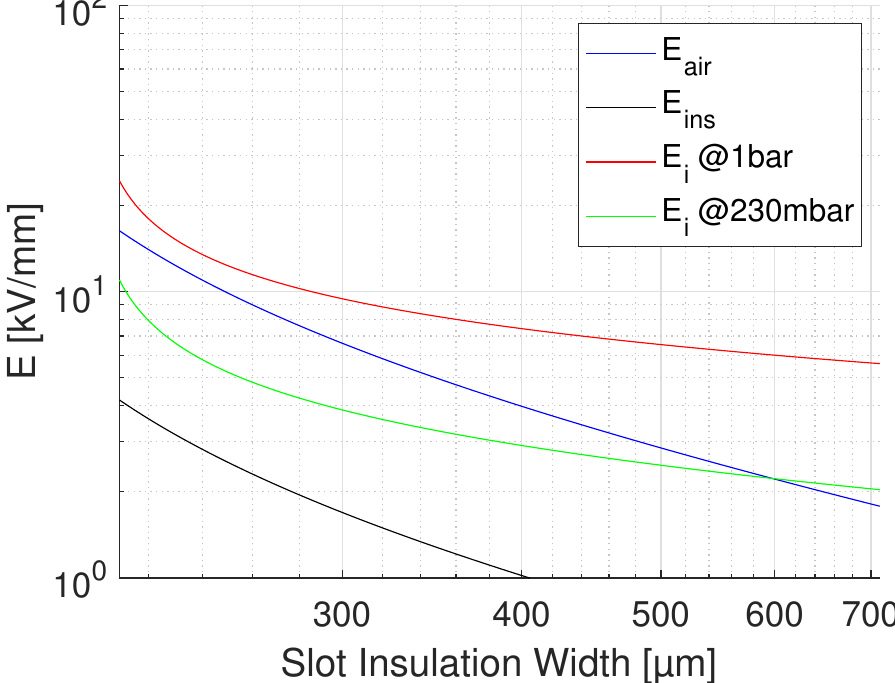
Figure 5. Behaviour of PD inception field, E i , as a function of air gap thickness (thus slot width) in a slot filled by an insulation layer of 200 µ m, nominal voltage 1 kV, (cid:101) rins = 3.9. Ground air pressure, 1 bar, and 230 mbar. The field in air and in insulation, and the design field are also